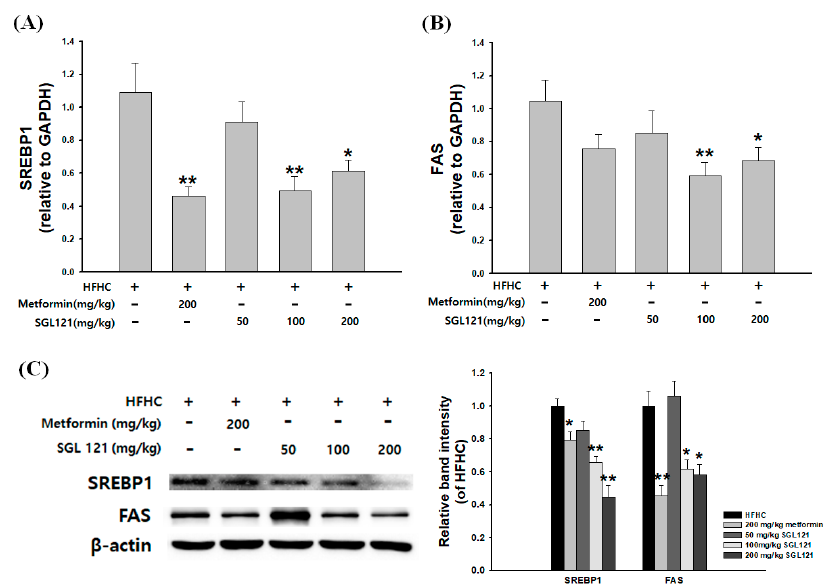
Figure 4. Effects of SGL 121 on hepatic lipid gene expression in NAFLD-induced mice. ( A ) sterol regulatory element-binding protein-1 (SREBP-1) mRNA levels, ( B ) fatty acid synthase (FAS) mRNA levels, ( C ) SREBP-1 and FAS protein expression levels. The graph indicates the expression level against β -actin expression level. Data are presented as the mean ± SE, n = 8. * p < 0.05 and ** p < 0.01 compared to the HFHC group.